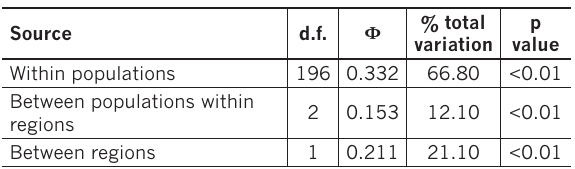
Table 4 . Results of the ‘large’ study AMOVA. Regions were either Arkansas or Oklahoma.